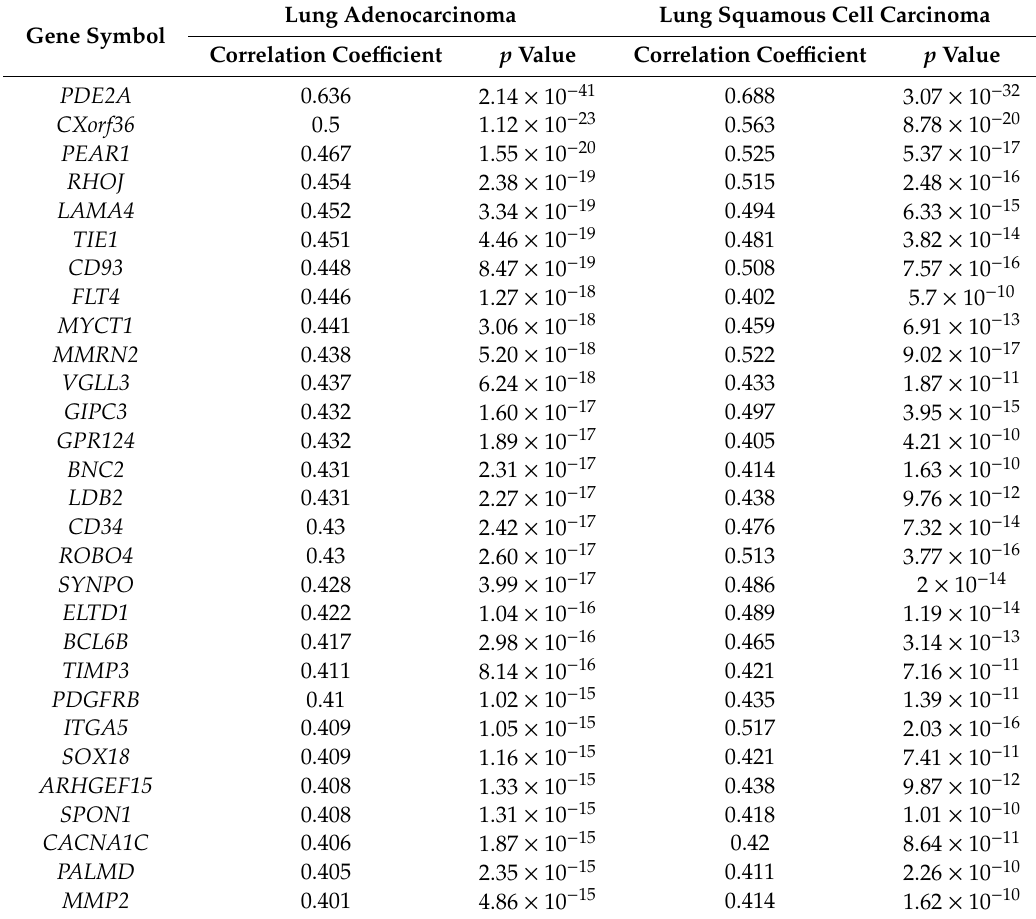
Table 1. List of genes whose expression were significantly correlated with LINC01537